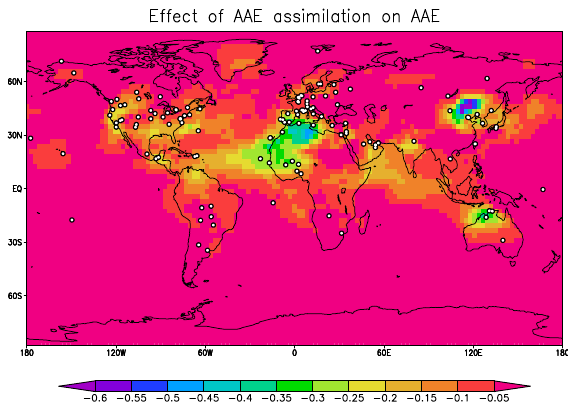
Fig. 22. Effect of assimilating AAE observations on AAE simulation. Shown is the time-averaged (8–24 July) difference between the experiments A1E2 and A2E2 from paper I.